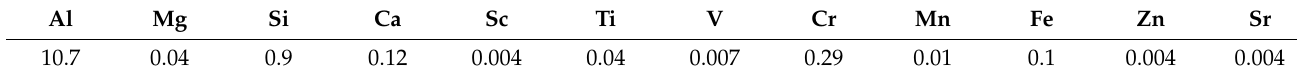
Table 5. Chemical composition of ACH precipitated from the mother liquor by saturation using gaseous HCl, wt.%.